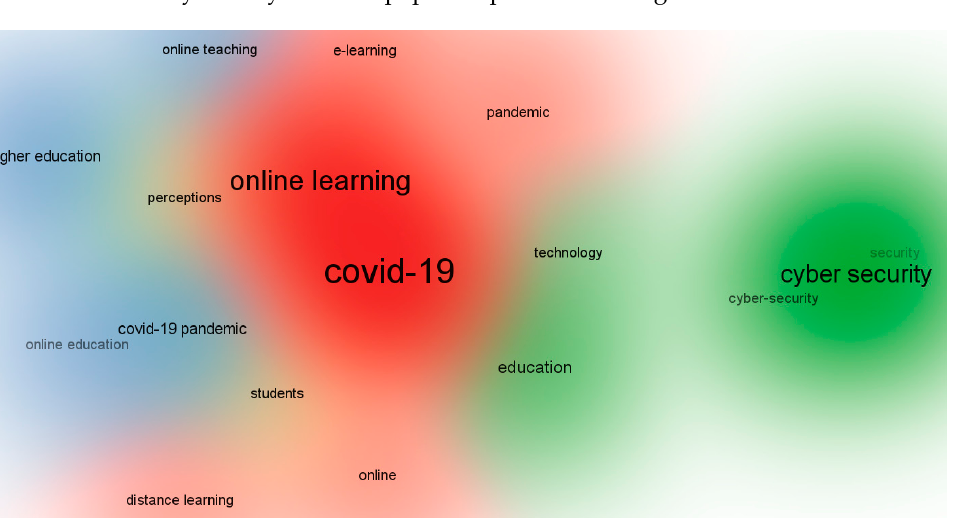
Figure 1. Keyword connection between the analyzed papers in search of an education organization security risk assessment model.